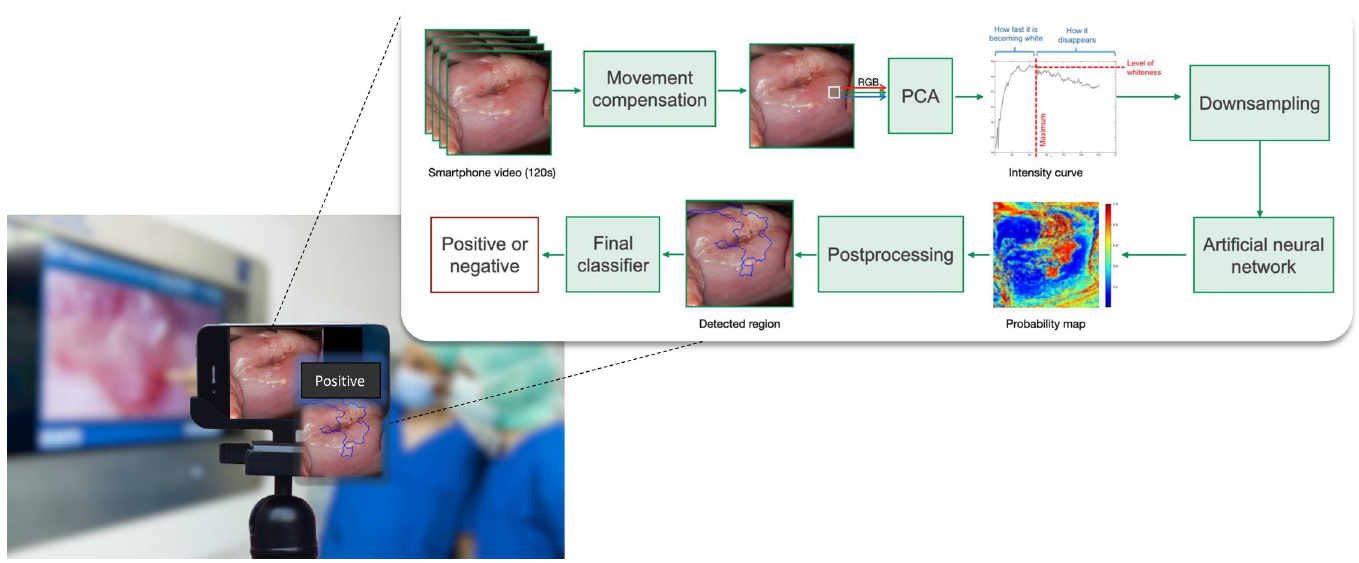
Fig 1. Process description of the AVC test. Adapted with permission from